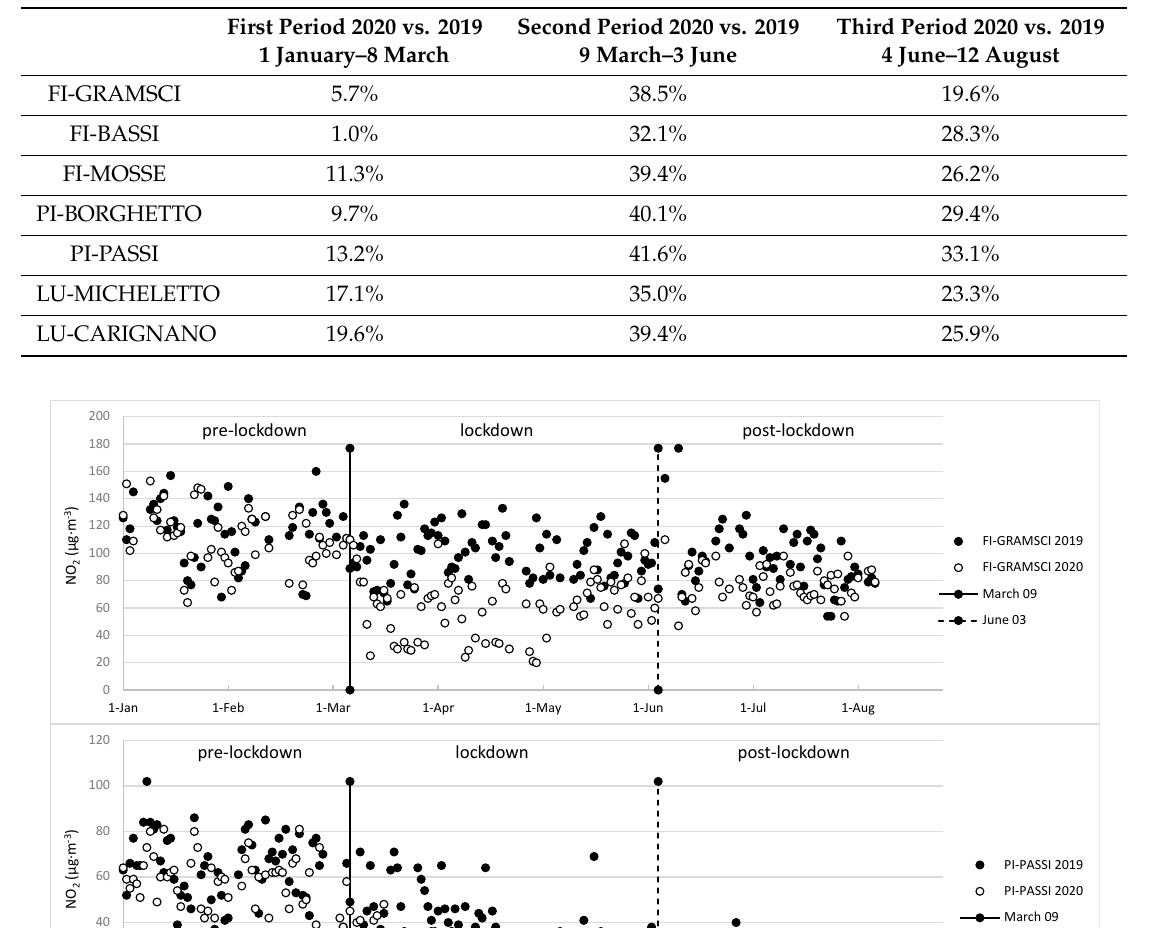
Table 5. Variations NO 2 ( µ g · m − 3 ) during the three periods.